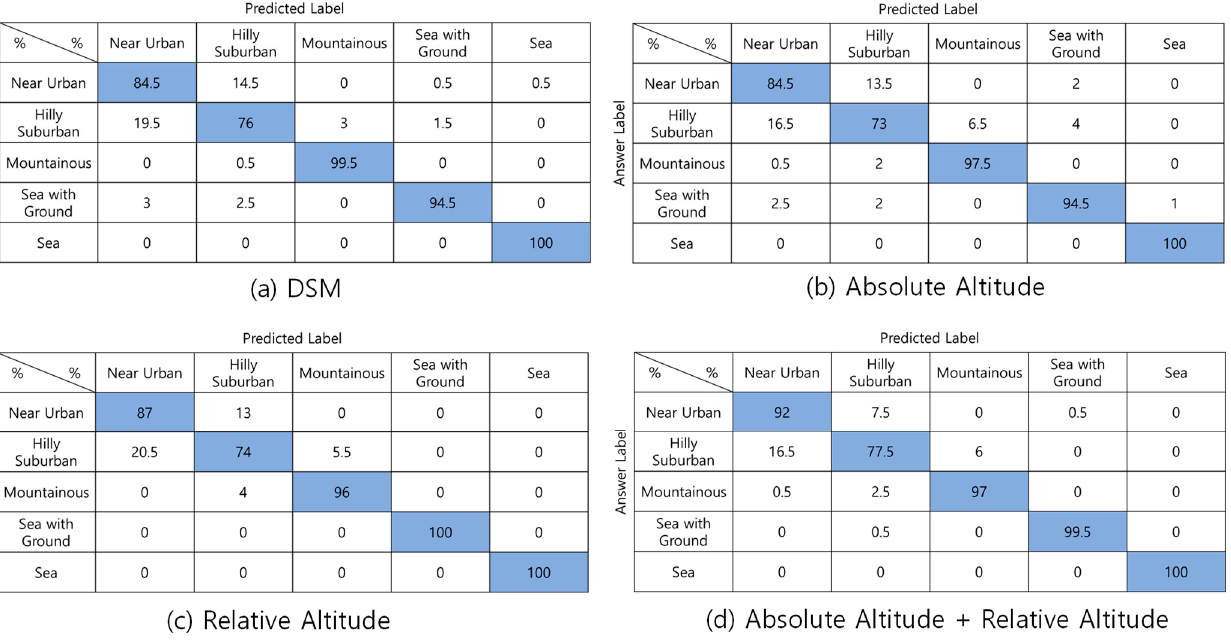
Figure 7. Confusion matrix of DNN-based one-step classification.